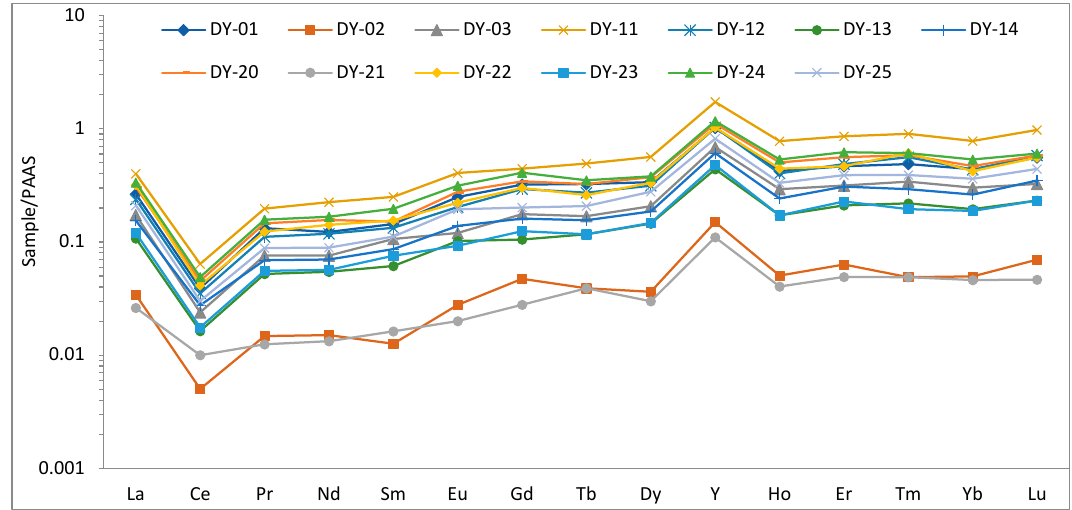
Figure 8. PAAS-normalized [59] REE pattern of the phosphate samples.